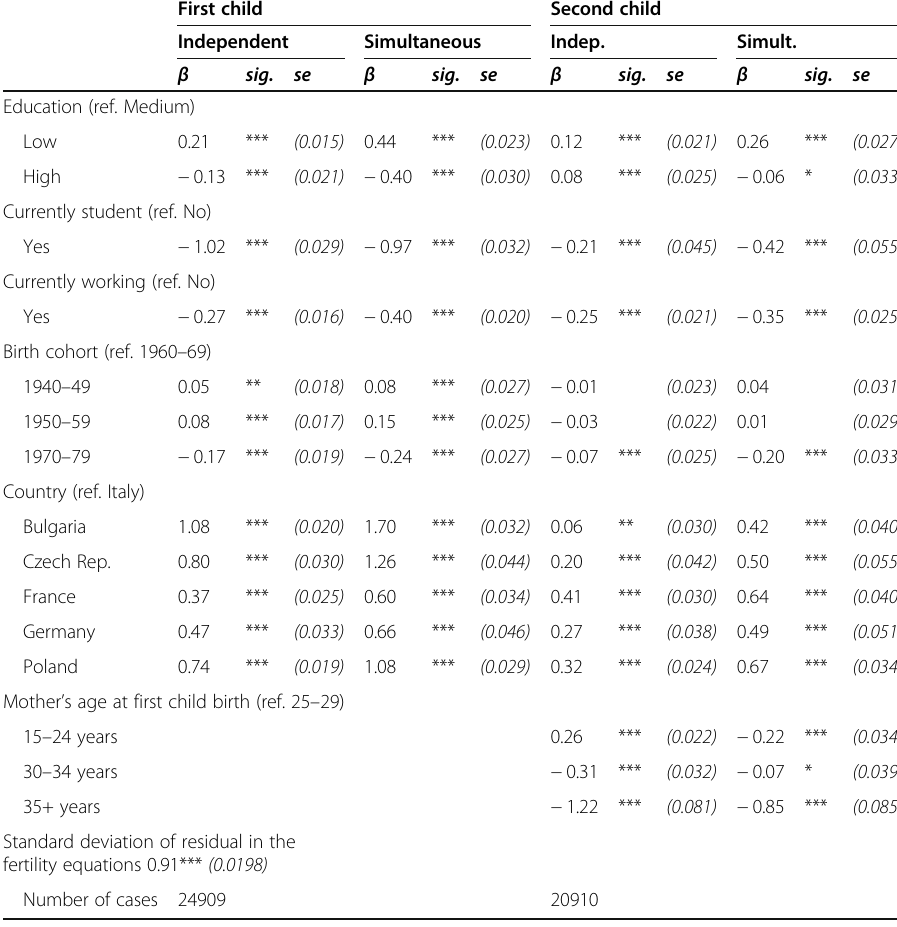
Table 2 Independent and simultaneous hazard models for the first and the second childbirth. Parameter estimates, significance values and standard errors First child Second child Independent Simultaneous Indep. Simult. β sig. se β sig. se β sig. se β sig.